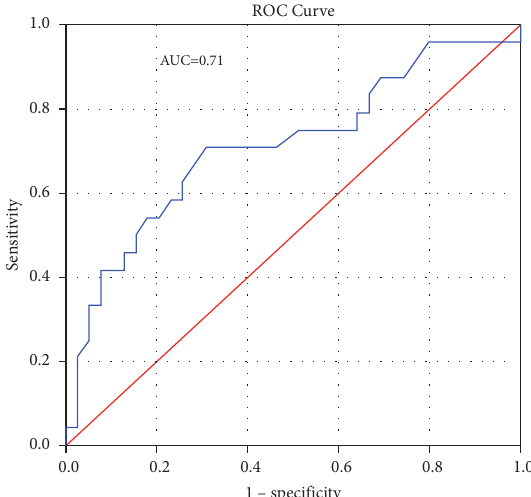
Figure 5: ROC analysis between LVMI and